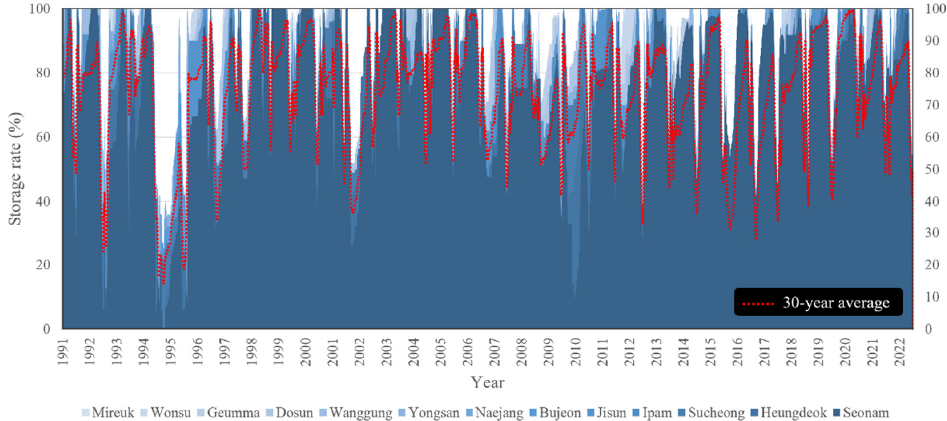
Table 1. Statistics on the specifications and storage rates of studied agricultural reservoirs